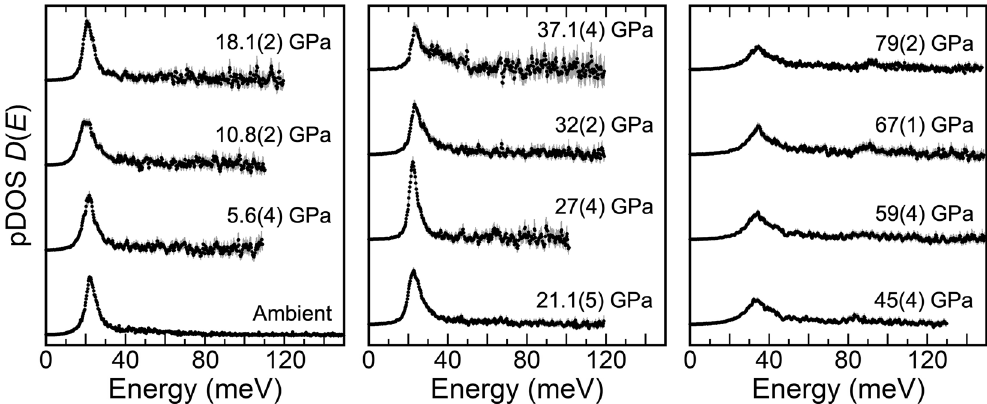
Figure 1. The partial projected phonon density of states (pDOS) of δ-(Al 0.87357 Fe 0.127 )OOH (δ-Fe13-r1) and δ-(Al 0.86757 Fe 0.133 )OOH (δ-Fe13-r2). The errors are indicated by shaded bars, and uncertainty in pressure is given in